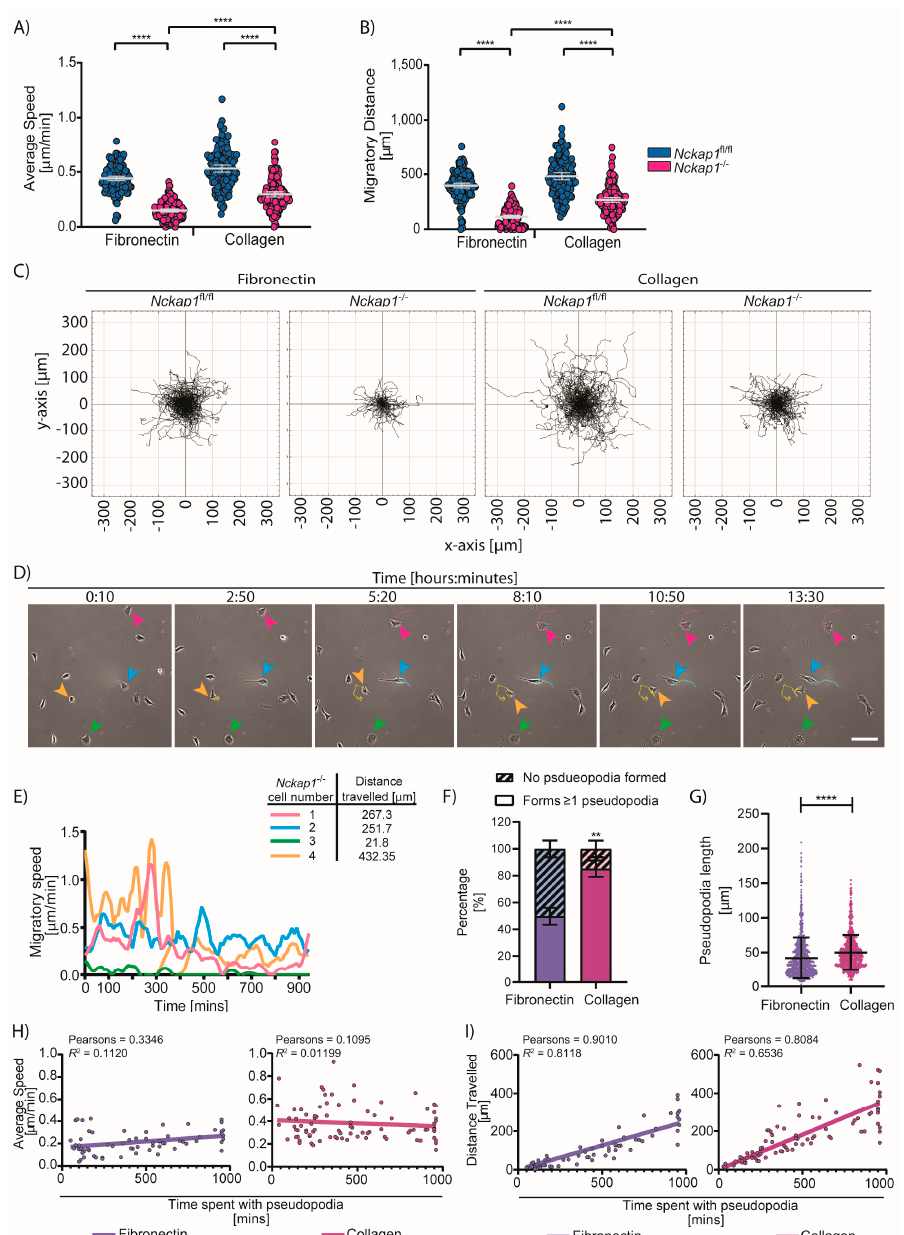
Figure 4. Collagen can partially rescue the migratory defect in Nckap1 KO cells. The random migration assay of the control and Nckap1 KO cells migrating over fibronectin and collagen is shown. ( A ) Migratory distance travelled, ( B ) average migratory speed. The dot plots present mean and S.D. from > 130 cells analysed for each condition from 2 independent experiments. Statistical significance was assessed using a 1-way ANOVA Kruskal-Wallis test, **** p < 0.0001. ( C ) Spider plots represent migratory paths and distance travelled. ( D , E ) Representative migratory profiles of four Nckap1 KO cells that represent rounded, pseudopod-like protrusions and cells that transition between the two phenotypes. Note: The green cell is rounded for the entire experiment and has very little speed or distance